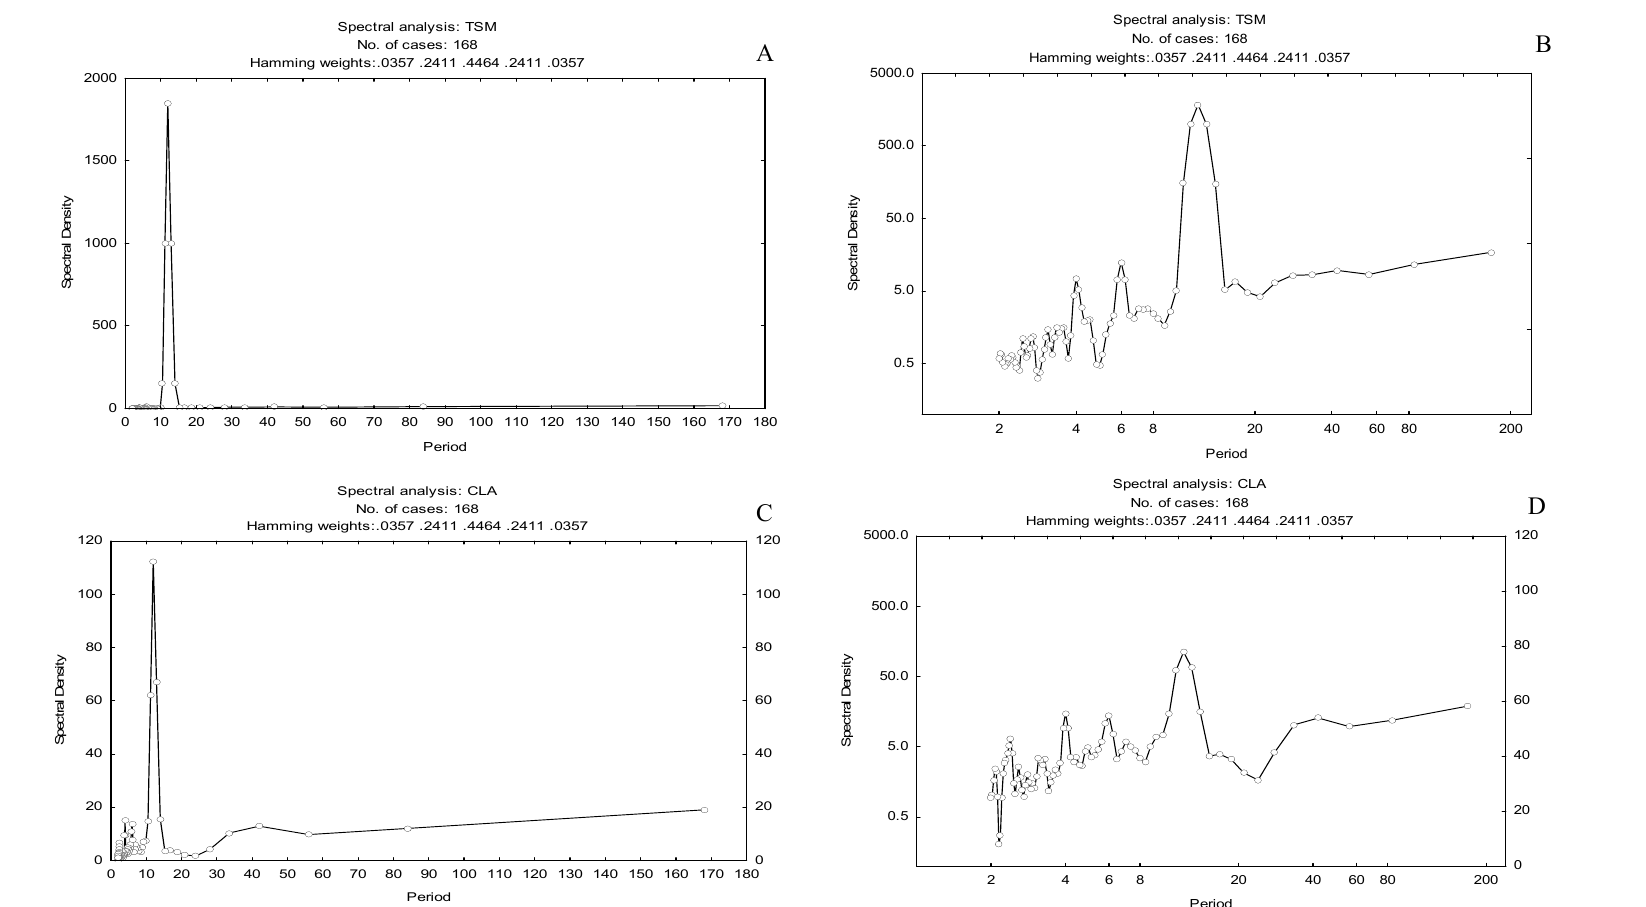
Figure 11. Spectral analysis and periodograms for sea surface temperature (SST) ( A , B ) and the concentration of chlorophyll a (Chl-a) ( C , D ).